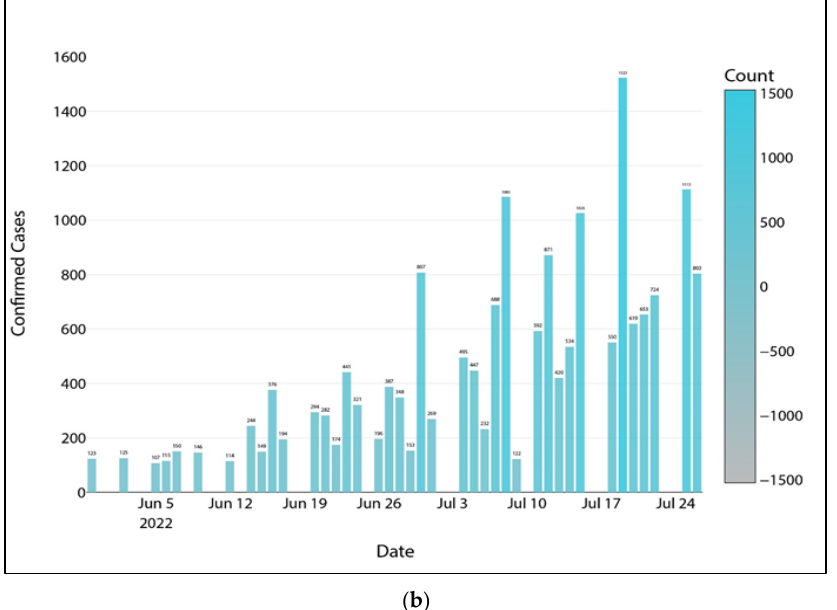
Figure 7. ( a ) Global confirmed cases ordered by date and ( b ) global confirmed cases numbering more than 100 on any given day.